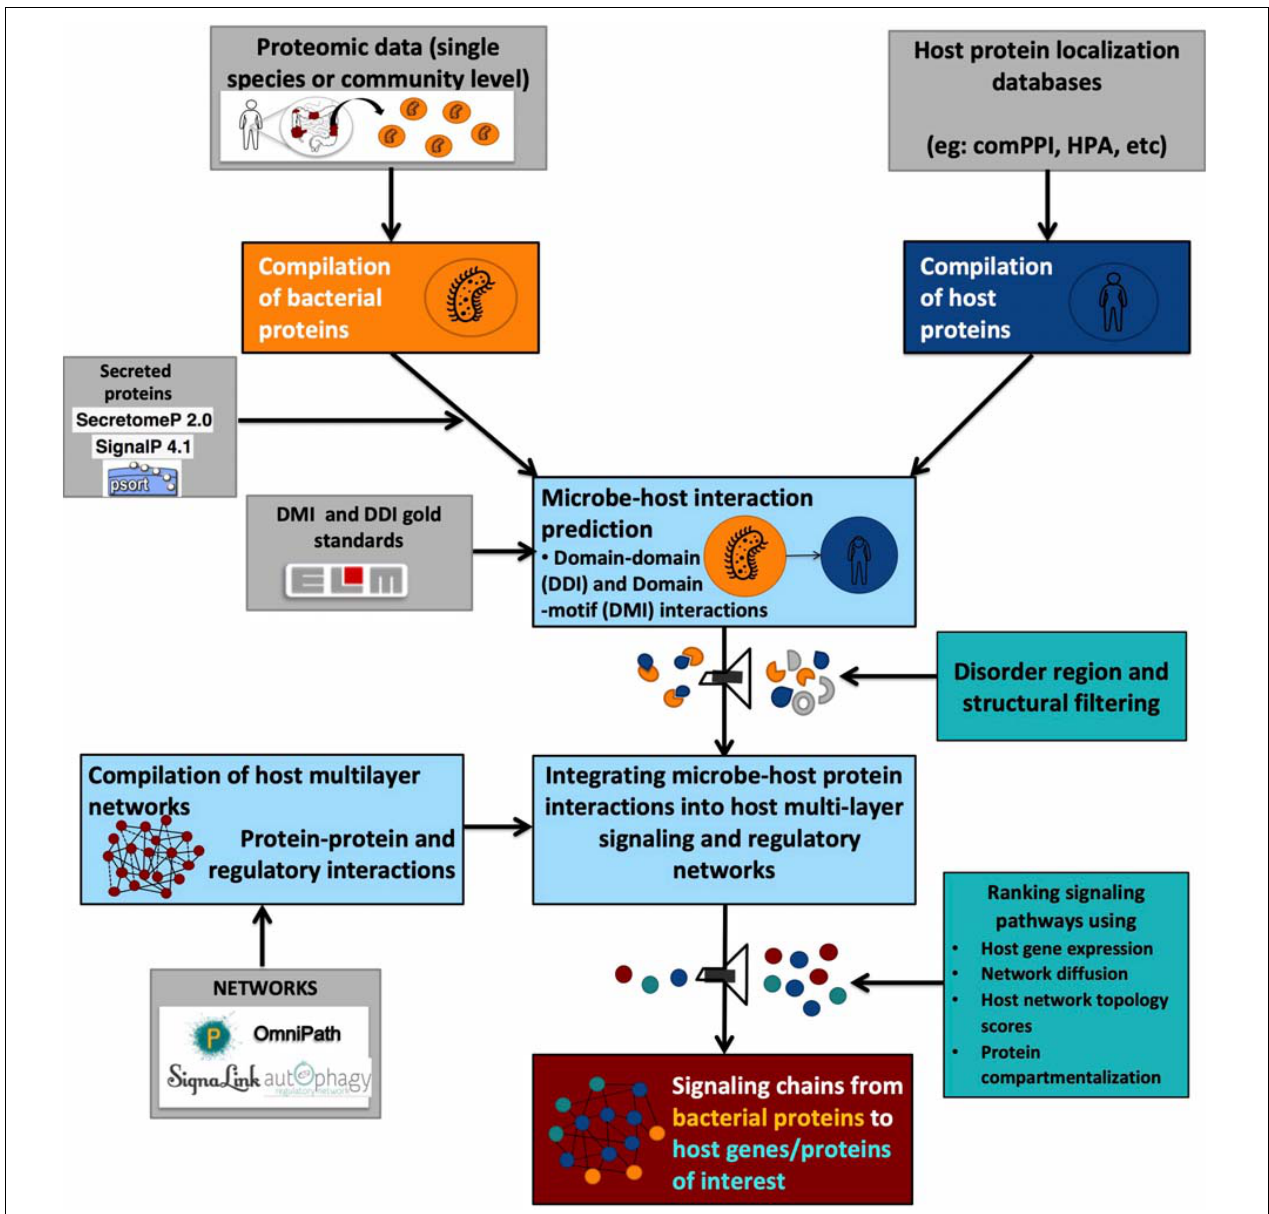
FIGURE 2 | Graphical representation of a typical integrated workflow predicting interactions between microbial and host proteins and their effect on host